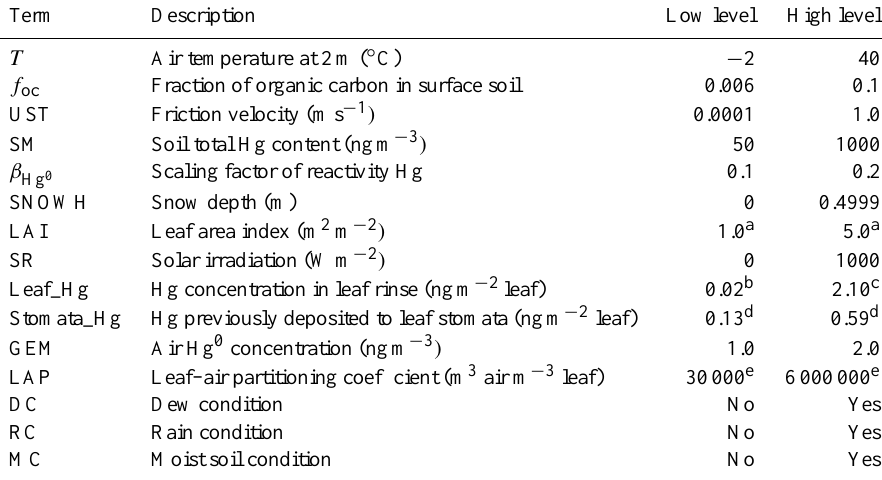
Table 4. Examined model variables and the experimental levels of factorial design for air–canopy